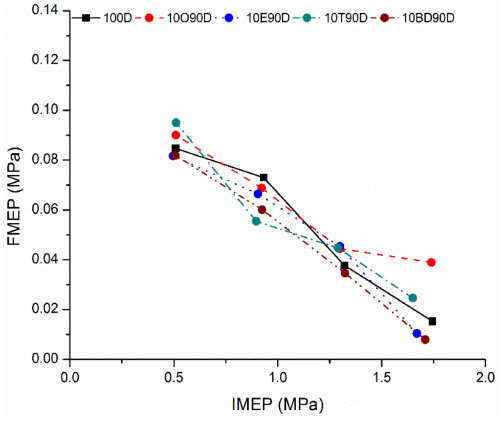
Figure 4. Frictional Mean Effective Pressure variation of tested fuel